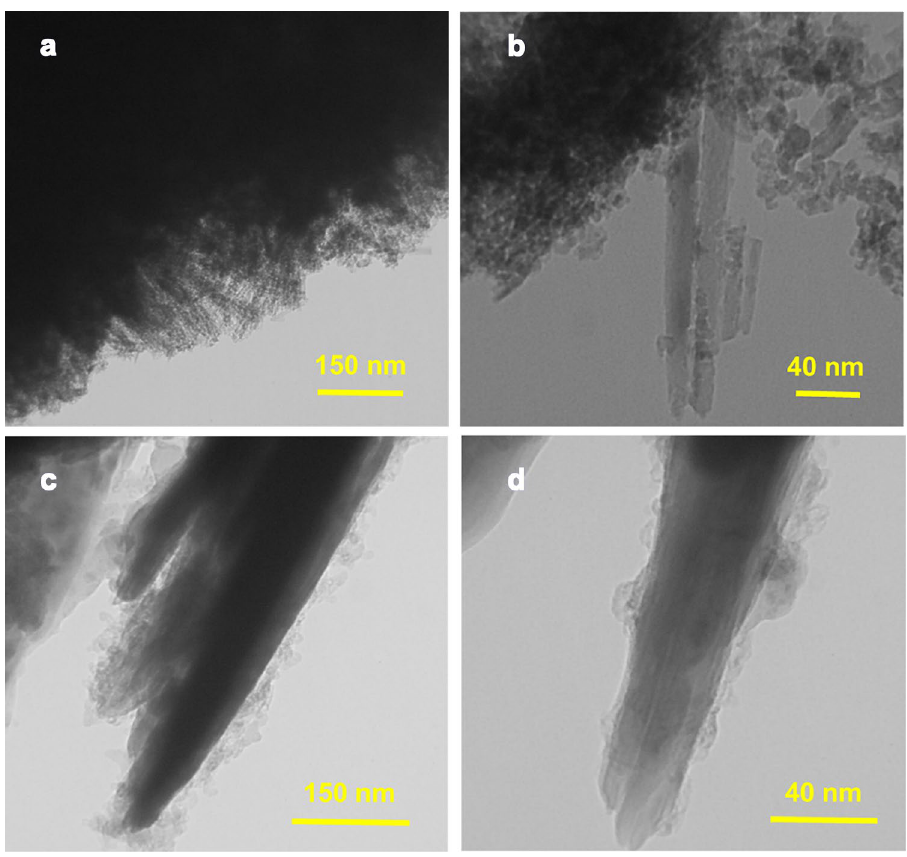
Figure 3. TEM images of ( a , b ) NiCo 2 S 4 and ( c , d ) NiCo 2 S 4 @PPy